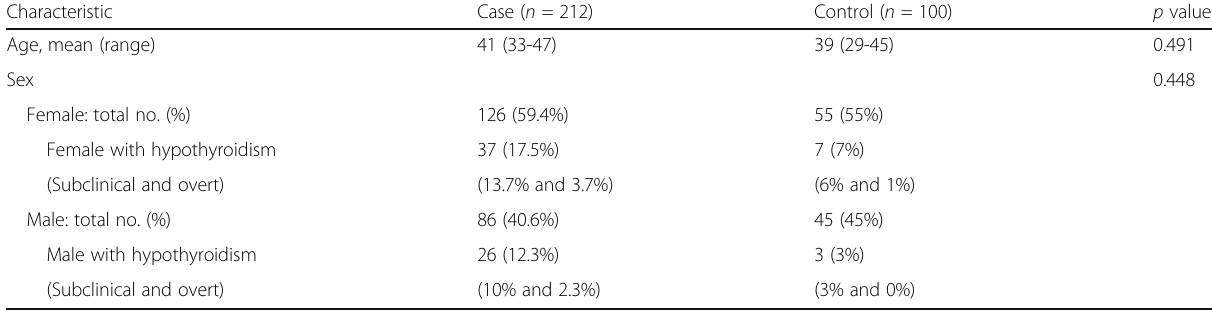
Table 1 Age and sex distribution between cases and control